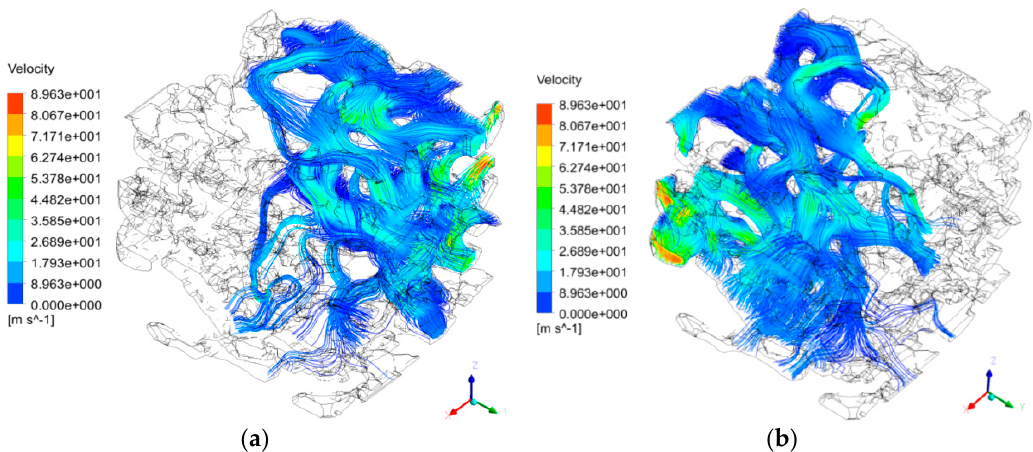
Figure 18. Seepage velocity distribution of dual-channels in the X and Y directions: ( a ) X direction; and ( b ) Y direction.